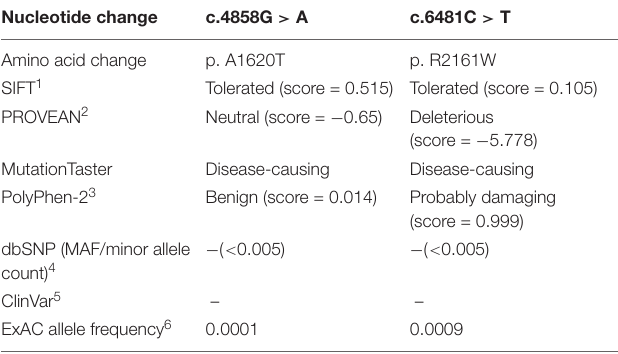
TABLE 1 | Bioinformatic analysis of ACACA mutations.